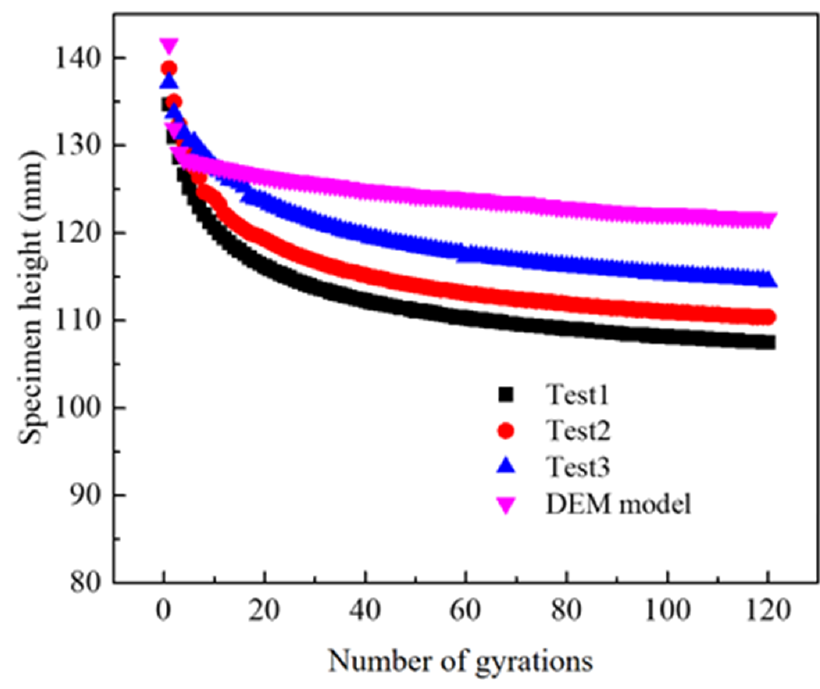
Figure 8. Specimen height change comparison between tests and the DEM